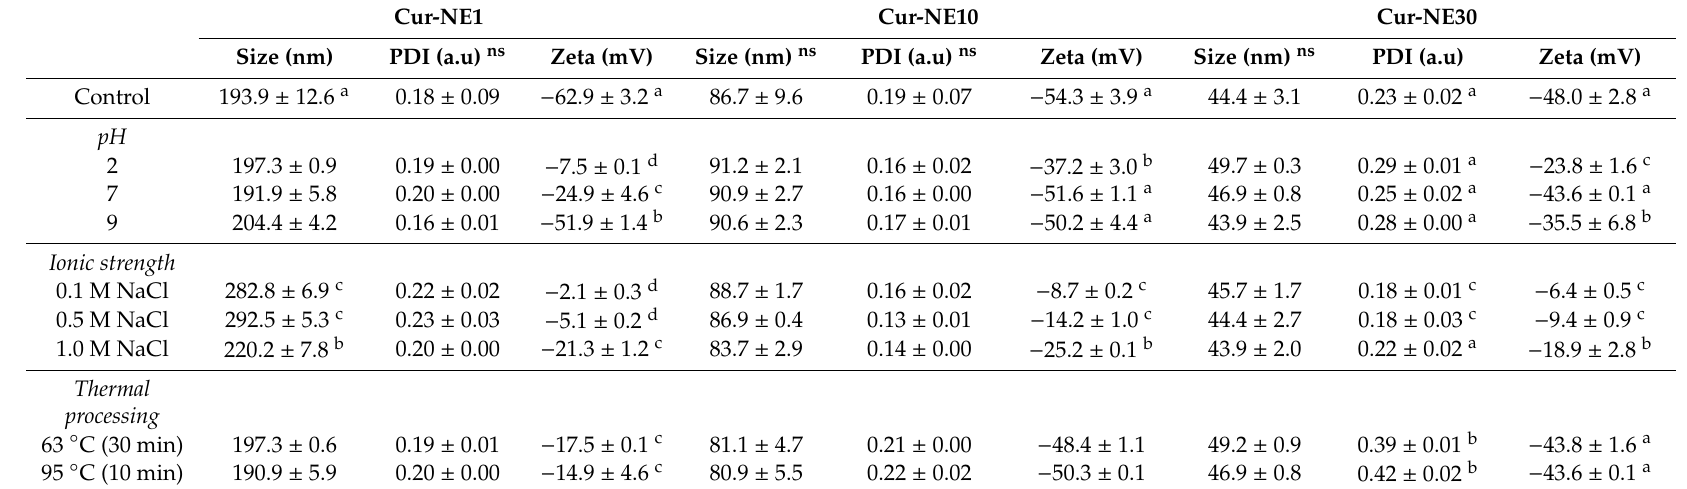
Table 2. Average diameter, size distribution, and surface charge of Cur-NEs under processing conditions.